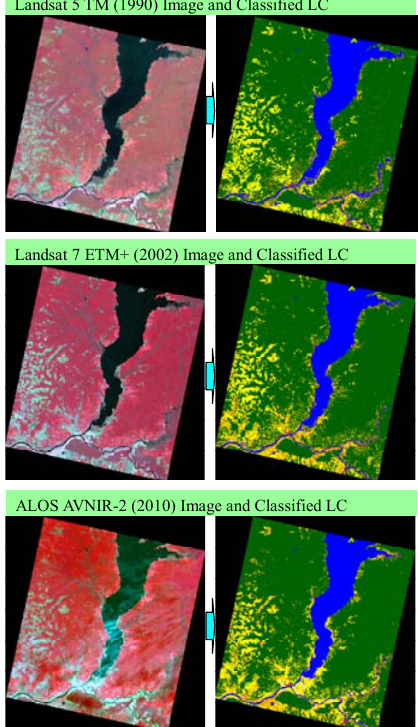
Figure 5. Satellite Image of 3 Epochs (bands 4, 3, 2 as R, G, B) and Classified LC